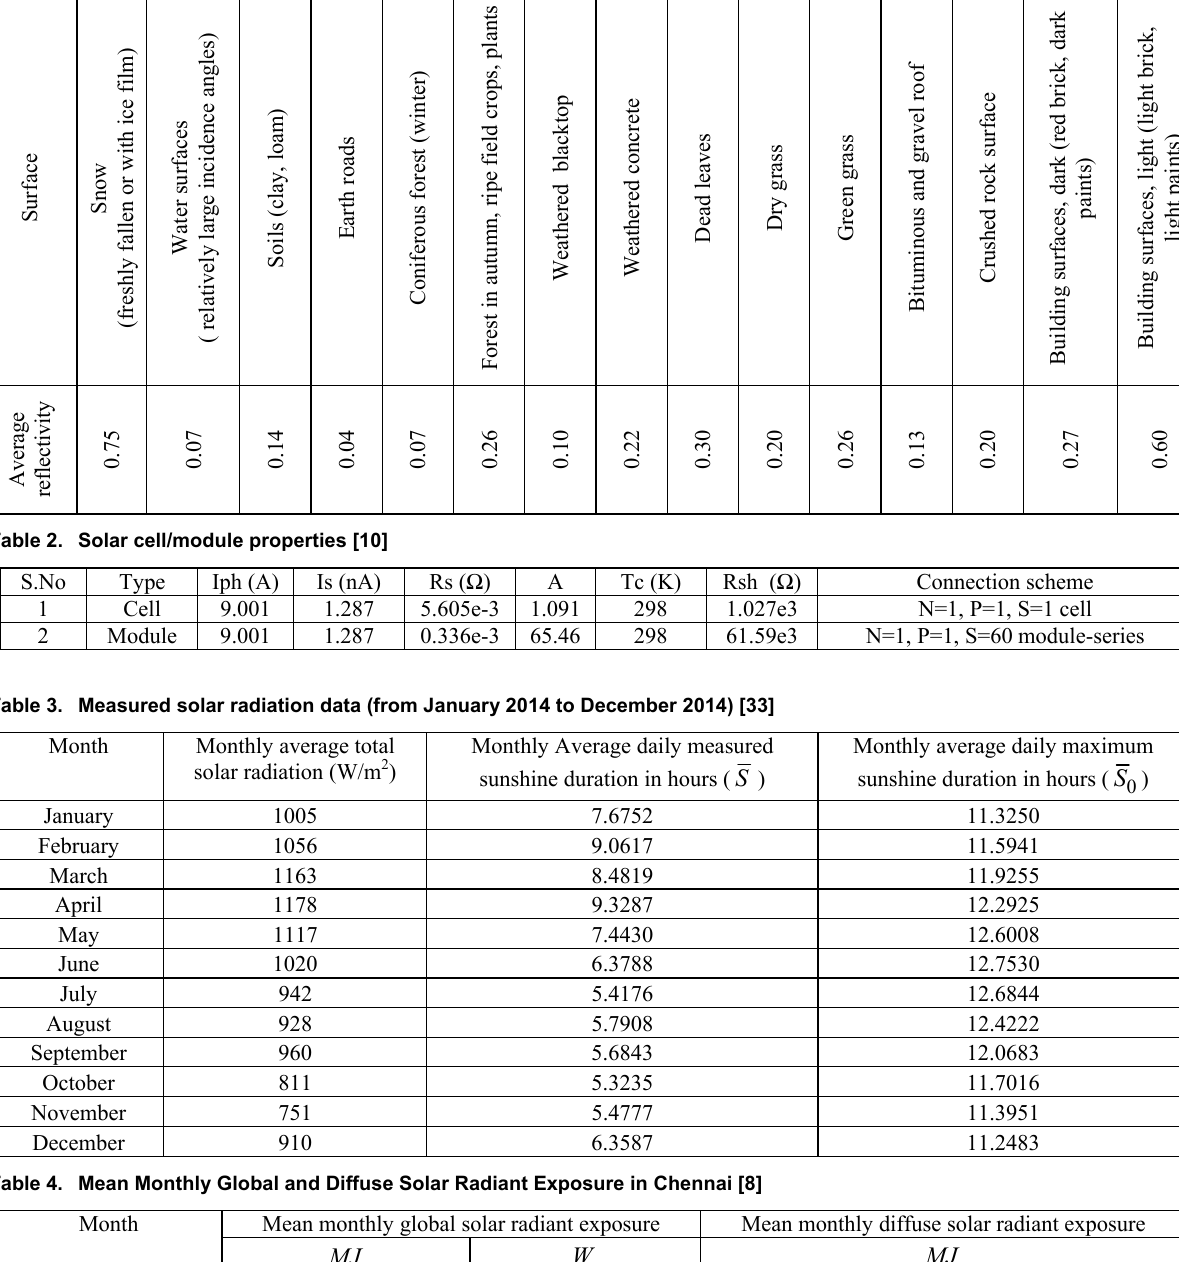
Table 1. Values of reflectivity on various ground surfaces [4] S.No